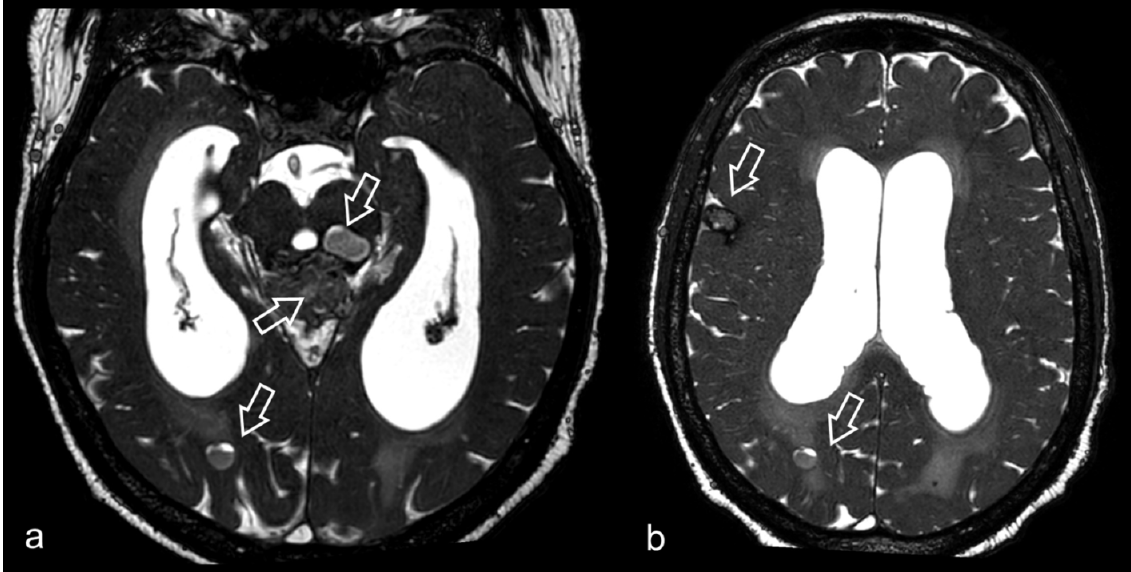
Figure 5. 61-year-old male patient presenting with long-standing headache. MRI shows multiple supratentorial and infratentorial lesions, variable in size (some of the most prominent indicated by arrows), all characterized by marked blooming artifact in susceptibility weighted sequence (not shown). 3D CISS images ( a , b ) clearly show the composite structure of each lesion, made of multiple heterogeneous locules consistent with hemorrhage in different phases, surrounded by a hypointense rim due to hemosiderin. The most conspicuous lesion centered in midbrain tectum compresses the cerebral aqueduct, causing supratentorial hydrocephalus.